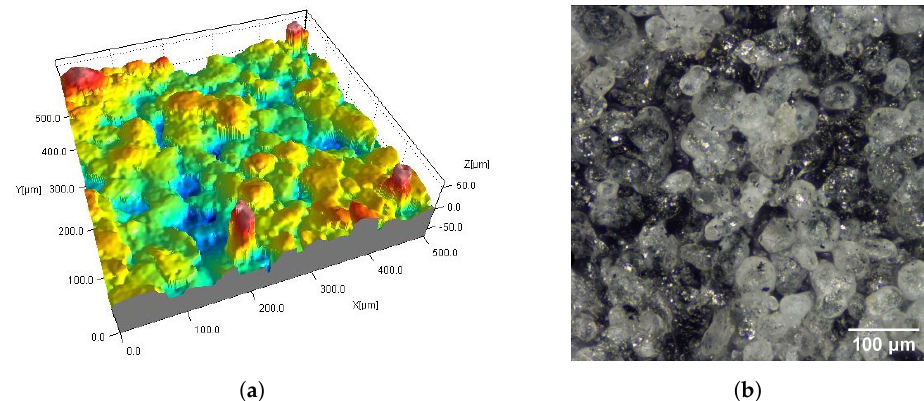
Figure 6. Surface of MJF sample without post-processing (Ref): fragment 0.5 mm × 0.5 mm of 3D map ( a ) and corresponding 2D view ( b ).